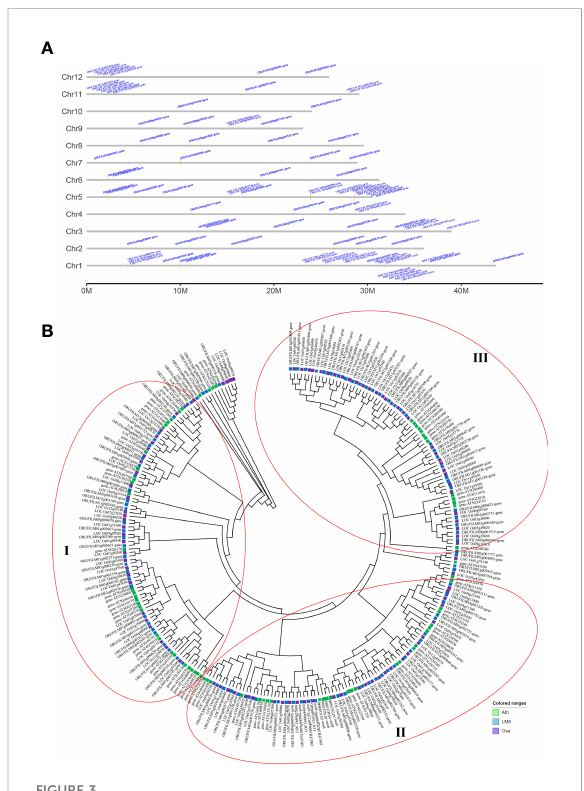
FIGURE 3 WRKY gene family analysis. (A) Distribution of WRKY genes across 12 chromosomes in the LM8 genome. (B) Phylogenetic tree containing WRKY genes from Arabidopsis, Nipponbare, and LM8. Ath, Arabidopsis thaliana ; Osa, Oryza sativa . Nipponbare was selected as a typical cultivated rice variety, whereas Ath and Osa served as controls. The conserved WRKY structural domains were used to classify the WRKY genes, which are indicated by three red